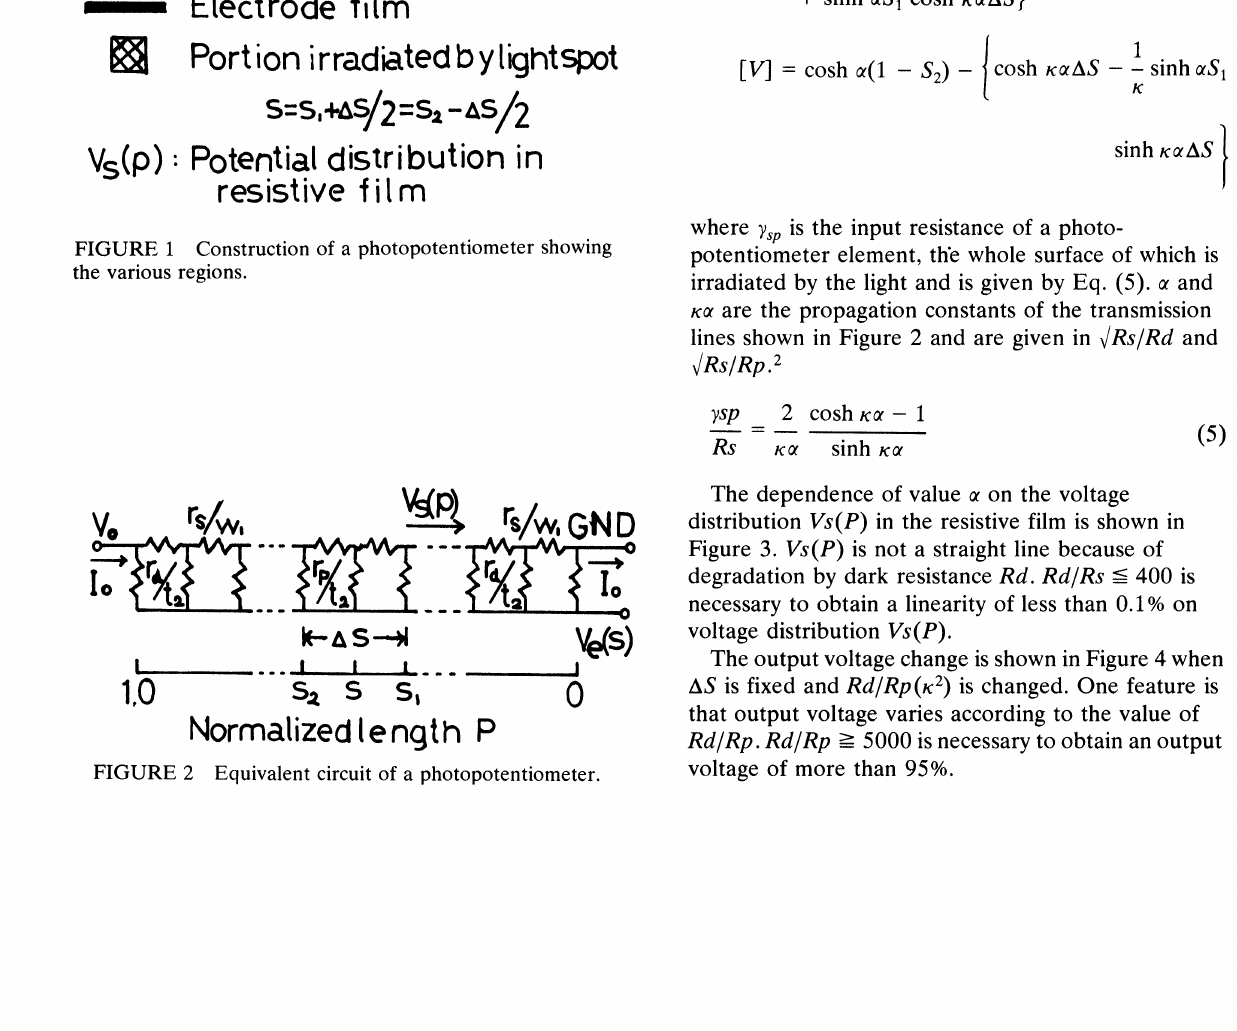
Construction of a photopotentiometer showing the various regions.